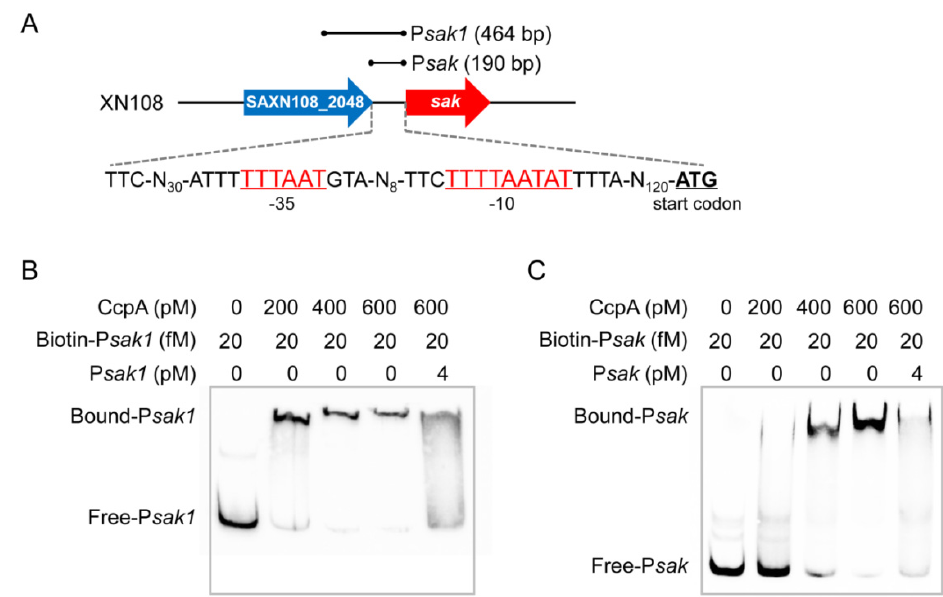
Figure 4. CcpA directly binds to the promoter region of sak . ( A ) Scheme of the gene organization and predicted promoter sequence. The − 35 and − 10 elements are underlined and labeled as red characters, the translational start codons are underlined and labeled as black bold characters. The location of probe P sak and P sak1 is depicted above, respectively. The arrows represent transcription direction of corresponding genes that not drawn to scale. ( B , C ) EMSA of purified CcpA with biotin-labeled and unlabeled probe P sak1 ( B ) and P sak ( C ). EMSA was conducted using increasing concentrations of CcpA (0 to 600 pM) and biotin-labeled probes (20 fM). A 200-fold excess of unlabeled fragments (4 pM) was added as cold